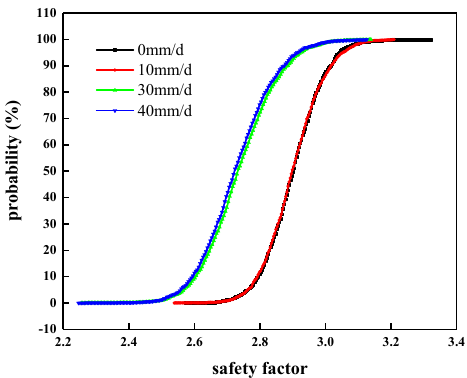
Figure 14. Probability density distribution of slope safety factor. Table 9. Statistics of various indexes of manganese slag slope under different rainfall intensities. Rainfall